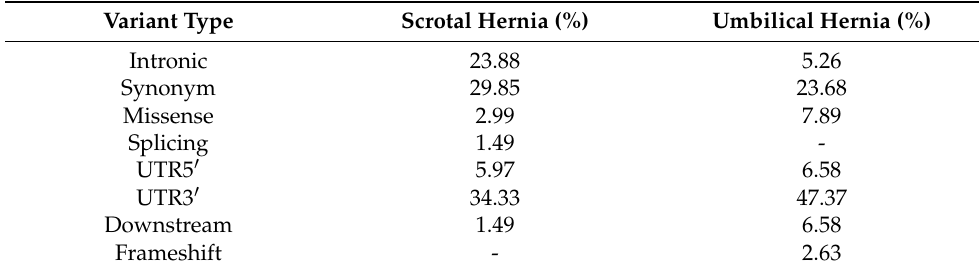
Table 6. Variants annotated in different functional classes in samples from inguinal and umbilical ring tissues.